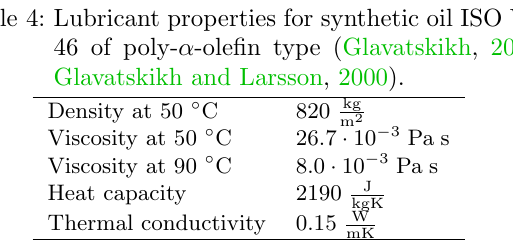
Figure 15: Schematic diagram of the test rig for the tilting-pad thrust bearing (Glavatskikh, 2000; Glavatskikh and Larsson, 2000): 1 - housing; 2,4 - test bearings; 3 - guiding holders; 5 - oil control ring; 6 - main shaft; 7 - load cell; 8,11 - discs; 9,10 - hydraulic cylinders.